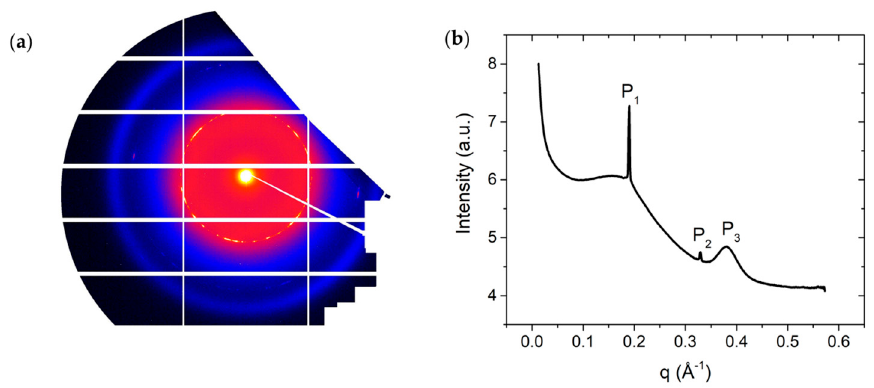
Figure 2. Definitions of the parameters d (lateral distance), s (neighboring columnar stacks), and w (stacking distance).